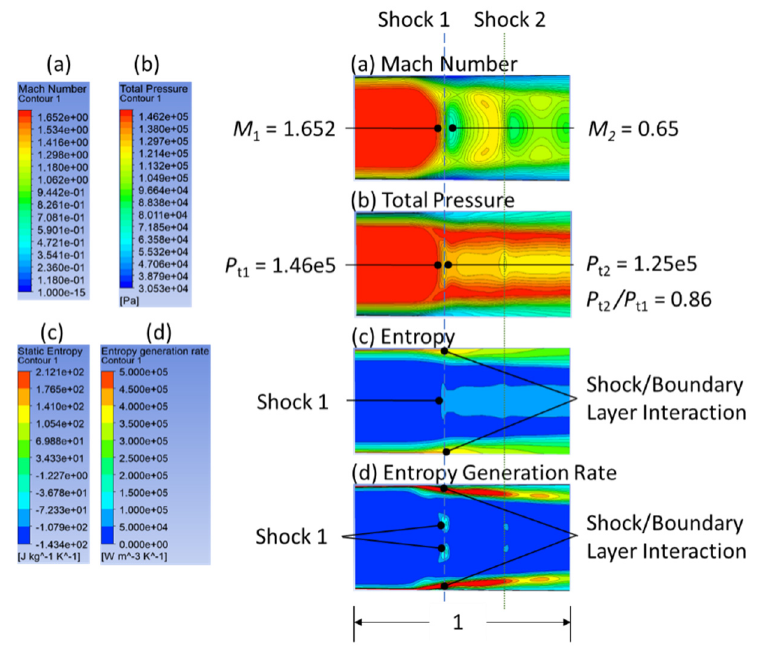
Figure 6. Contours of Mach number, static pressure, static entropy, and EGR within subsection 1 of Figure 5.